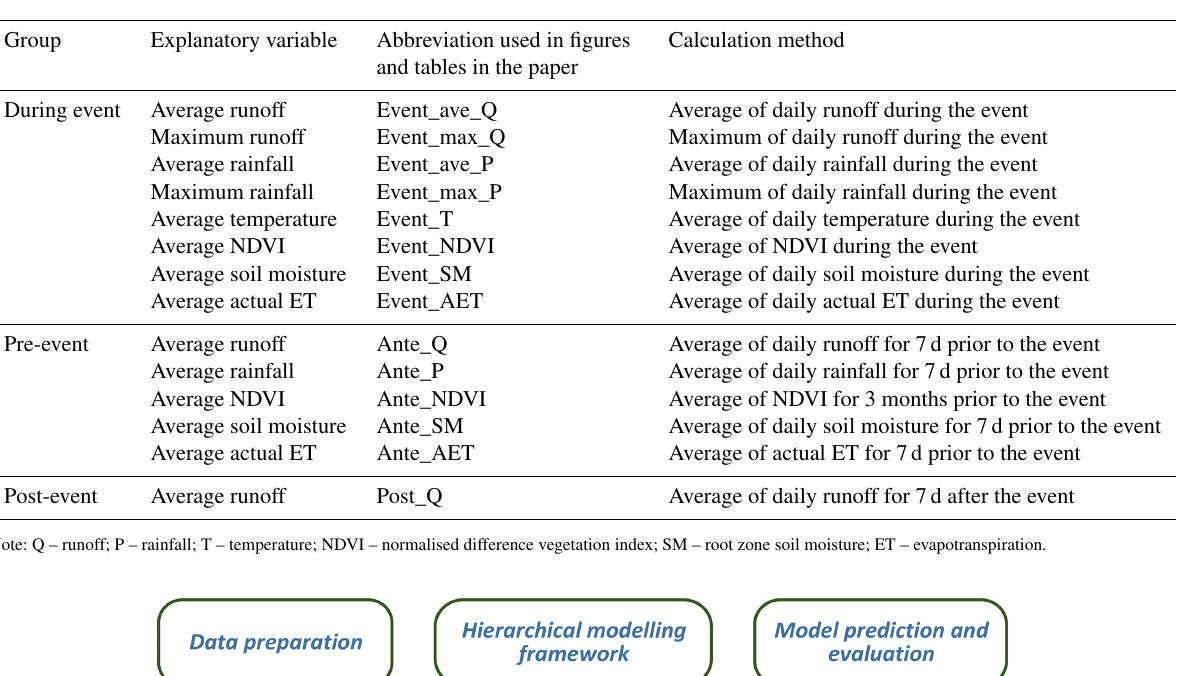
Table 3. The three groups of event characteristics and the averaging method.